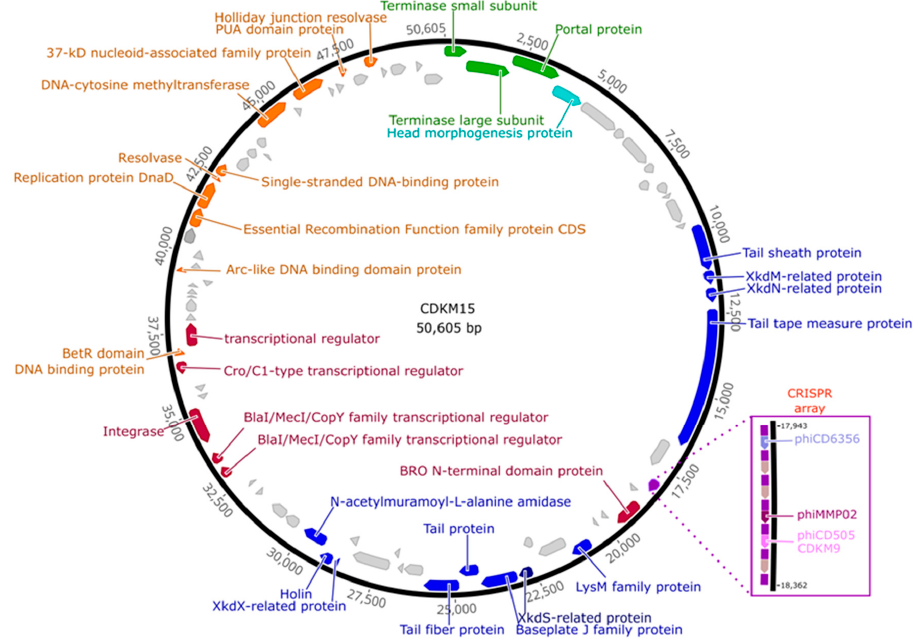
Figure 3. Genome organisation of CDKM15. The 50,605 bp genome assembled as a circle, shown here oriented to start at the terminase small subunit gene. Predicted coding DNA sequences (CDSs) are marked with arrows and colours indicate functional modules: head packaging (green), head (aquamarine), tail and lysis (blue), lysogenic conversion (purple) and DNA replication (orange). CDSs with no function assigned are light grey. Functional annotations are labelled. The clustered regularly interspaced short palindromic repeats (CRISPR) array is marked with a mauve arrow. The CRISPR array and its spacers are highlighted with spacer matches indicated.